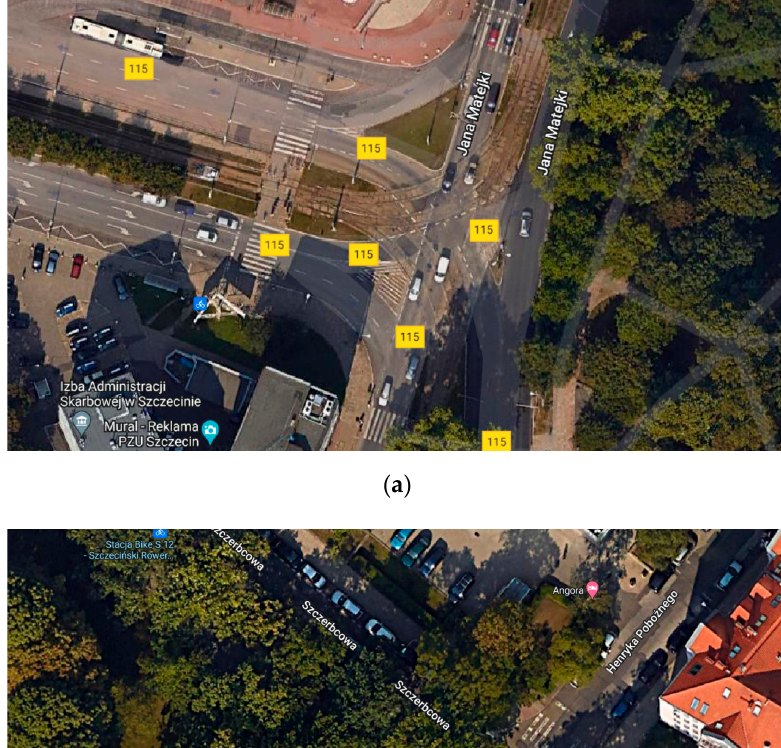
Figure 1. Location of key crosswalks (Five Stars). A satellite view of each of the five identified crossings is presented below (Figure 2).